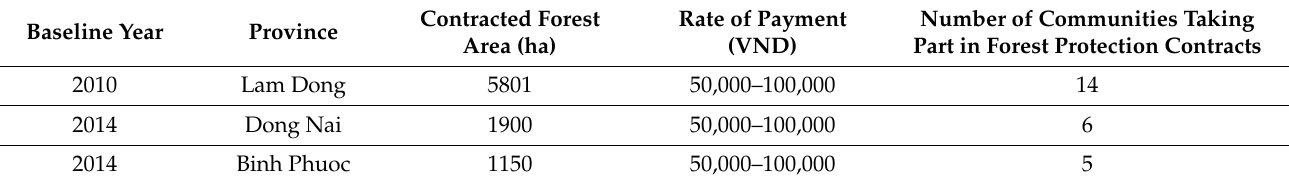
Table 2. Baselines for Cat Tien National